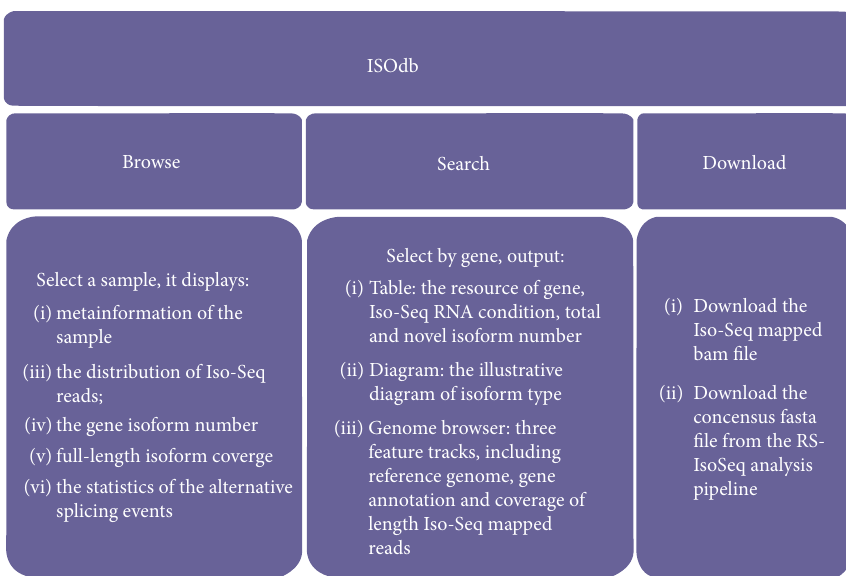
Figure 2: The main functions of